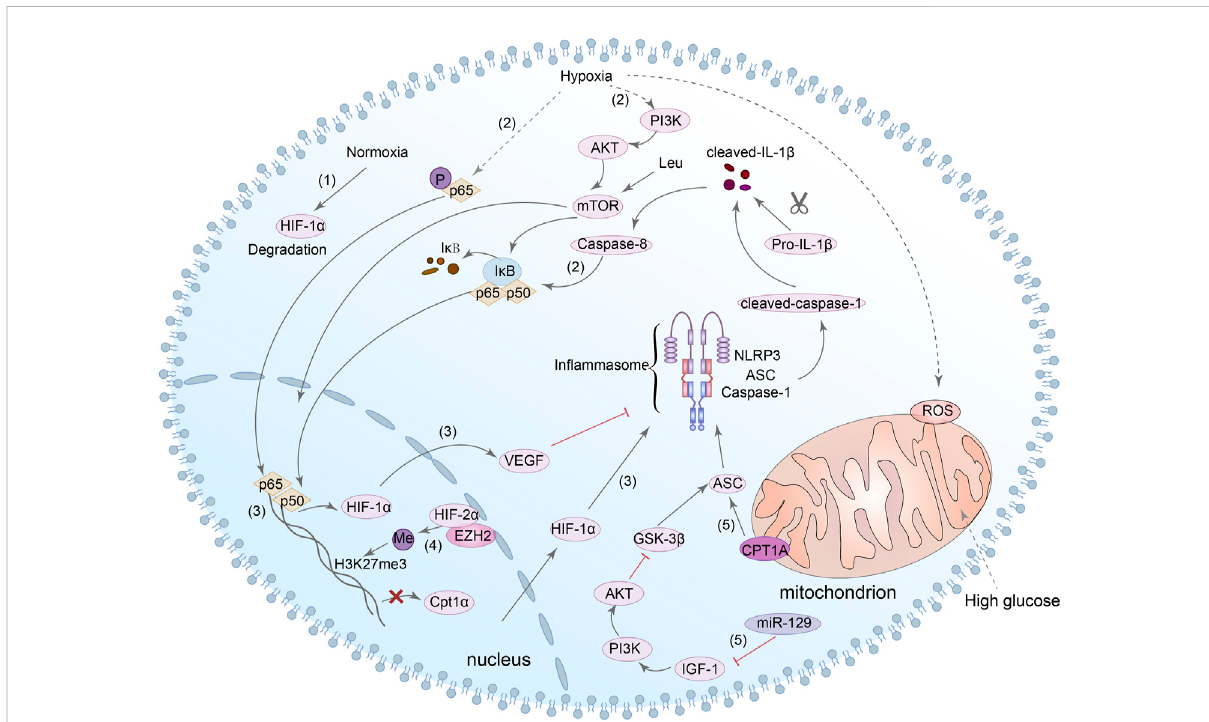
FIGURE 5 HIF-1 α /NLRP3 signaling pathway is involved in the regulation of pyroptosis. (1) HIF-1 α can be degraded in normoxia. (2) In hypoxia, NF- κ B and PI3K/Akt/mTOR/NF- κ B signaling pathway can be activated, and caspase-8 can also promote the nuclear translocation of NF- κ B. (3) NF- κ B directly boundtotheHIF-1 α promoterandenhanceditstranscription.HIF-1 α couldmodulatetheactivationoftheNLRP3in fl ammasome,andtheincreasein VEGF-AcanalsoresultinNLRP3in fl ammasomeactivation.(4)HIF-2 α